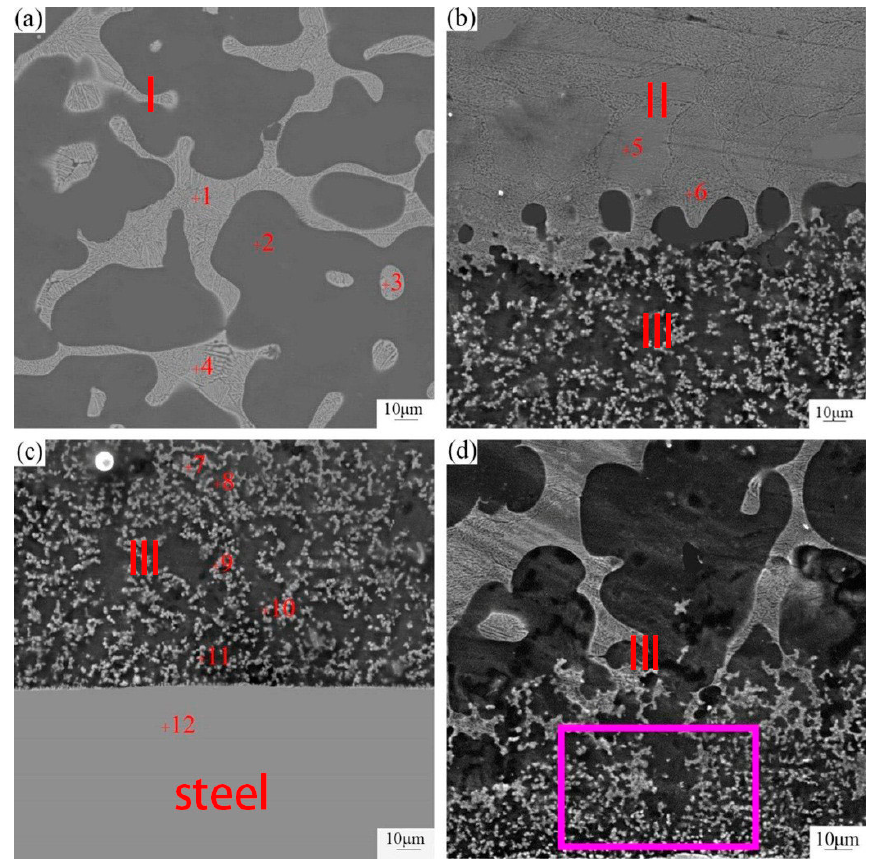
Figure 7. SEM image of the three different layers in galvanized-steel/AZ91D bimetallic material. ( a ) area of layer I in Figure 5a; ( b ) area of the interface between layer I and II in Figure 5a; ( c ) area of the interface between layer III and steel in Figure 5a; and ( d ) area of layer III in Figure 5a.